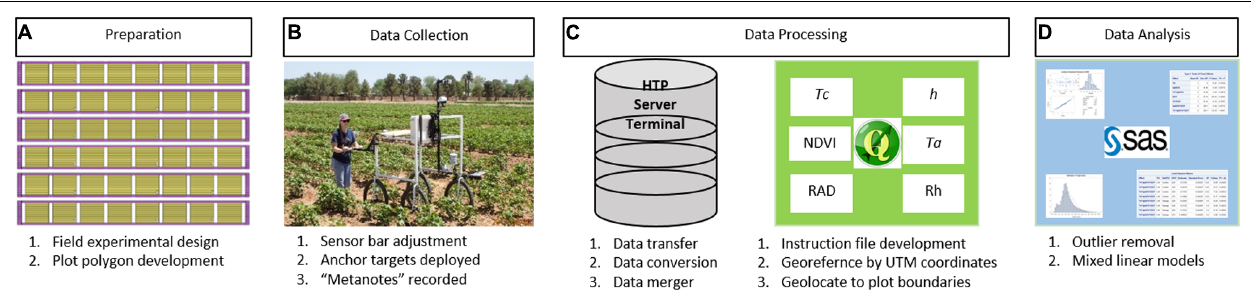
FIGURE 2 | A general workflow for field-based, high-throughput phenotyping using a proximal sensing cart equipped with multiple non-contact sensors and RGB cameras to assess cotton responses to water deficit used in this paper. The workflow starts with experimental and field preparation (A) then deployment of the cart for data collection (B) followed by data processing (C) and ending with data analysis (D) . Verbal and written informed consent was obtained for (B) from the depicted individual for the publication.